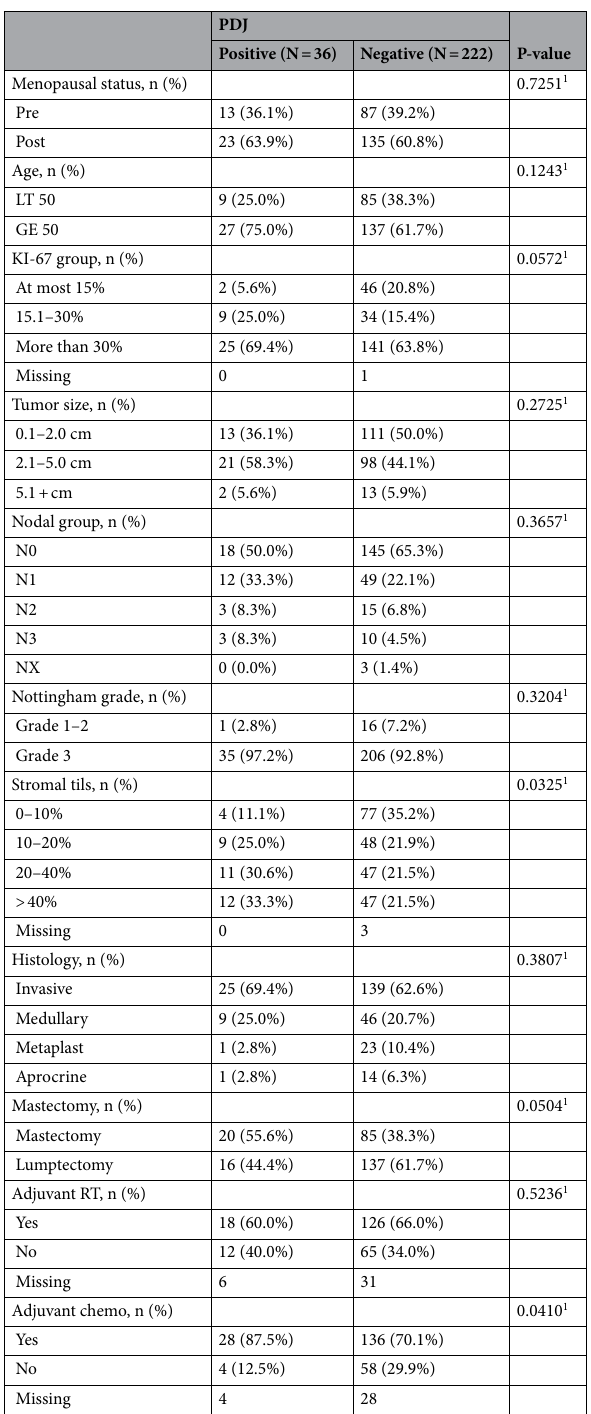
Table 3. The Mayo Clinic Breast Cancer SPORE TMA. 1 Chi-Square p-value.